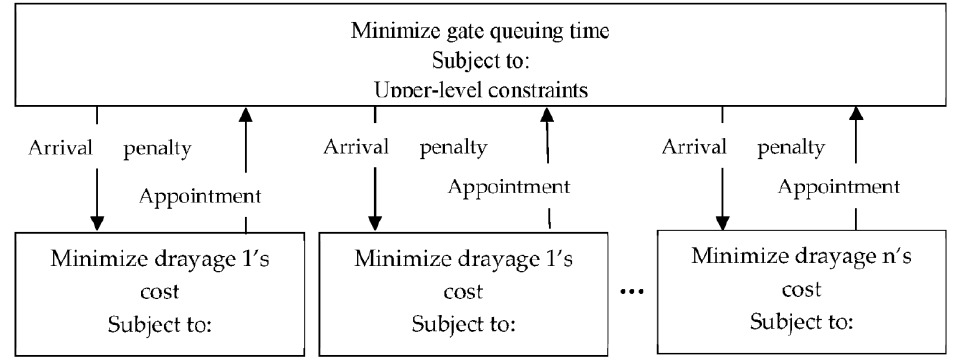
Figure 2. Illustration of interplay between the players.